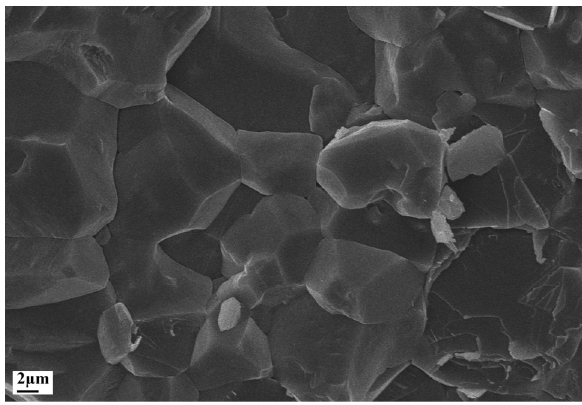
Figure 2: Microstructure of